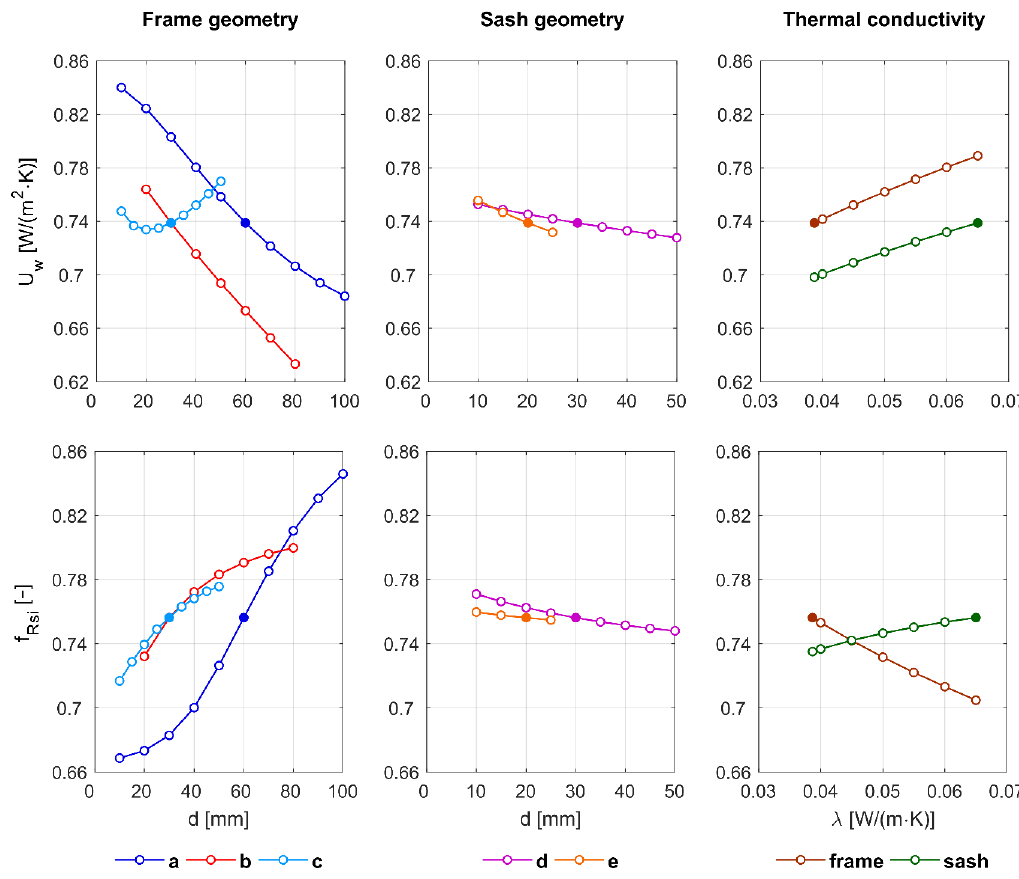
Figure 12. Key tendencies discovered in the parametric studies, expressed as the thermal transmittance of the whole window and as the surface temperature factor. Filled points represent basis values. For legend, see Figure 11.